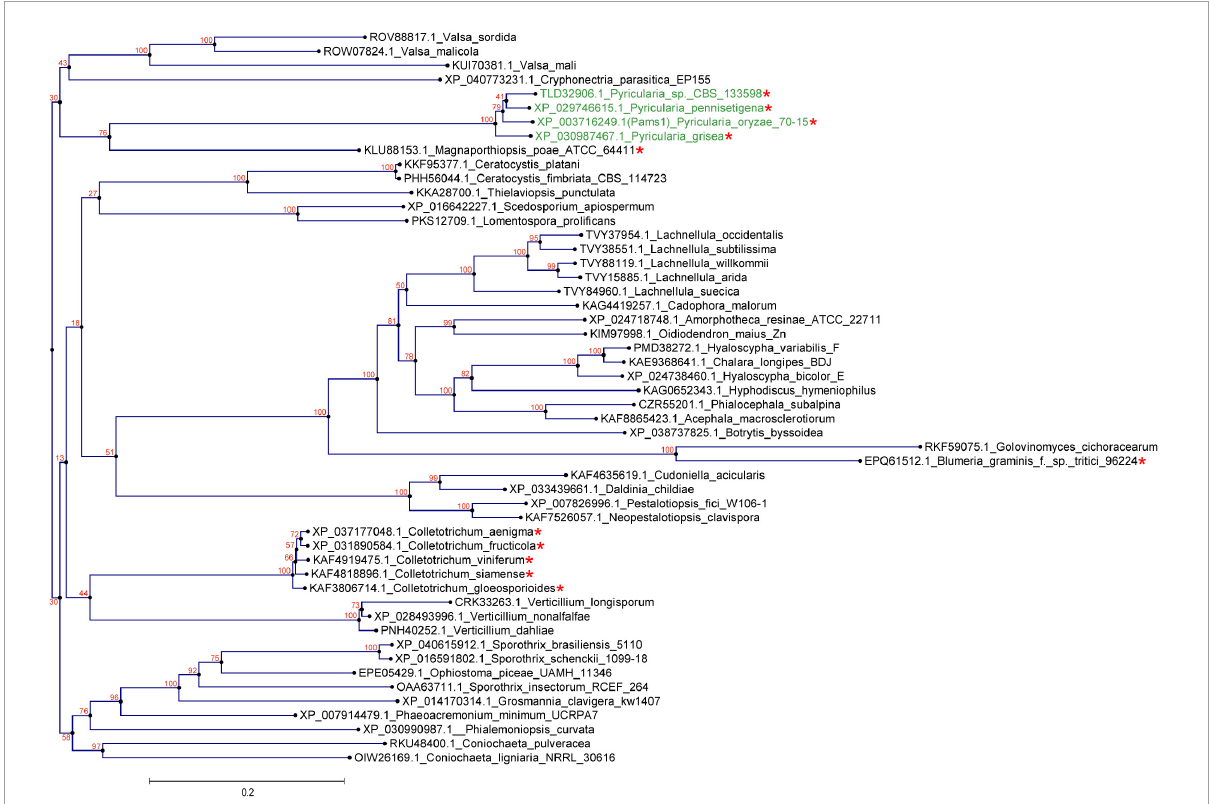
FIGURE2 Homologs of Pams1 are present in other fungi. Phylogenetic tree (constructed by the neighbor-joining method) of Pams1 homologs. The proteins used to build this tree were selected from the top 100 homologs of Pams1 with E -values < 9.1E-176 obtained by BLAST search of the NCBI protein database. The top five species with the smallest E -values in a genus were first selected, and then one protein from each species with the smallest E -value was selected. M. oryzae (syn. Pyricularia oryzae ) and related three species of Pyricularia ( Magnaporthe -like sexual morphs) are indicated in green. Asterisks indicate species that form appressoria or appressoria-like structures. The numbers at branch nodes are the bootstrap values. The scale bar indicates amino acid substitutions per